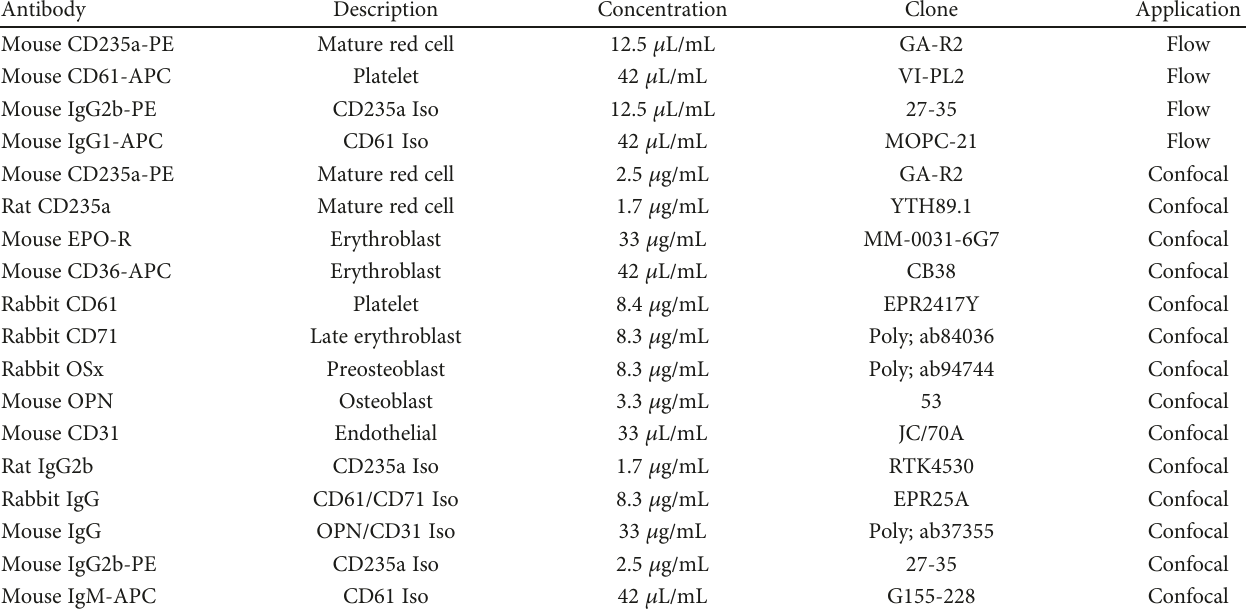
Table 1: Primary antihuman antibody stains implemented for fl ow cytometry and confocal microscopy. Including primary antibody host species, conjugation if applicable, a brief description, fi nal stained concentration or dilution, clone (if monoclonal) or AbCam product number (if polyclonal), and whether used in fl ow cytometry ( fl ow) or confocal microscopy